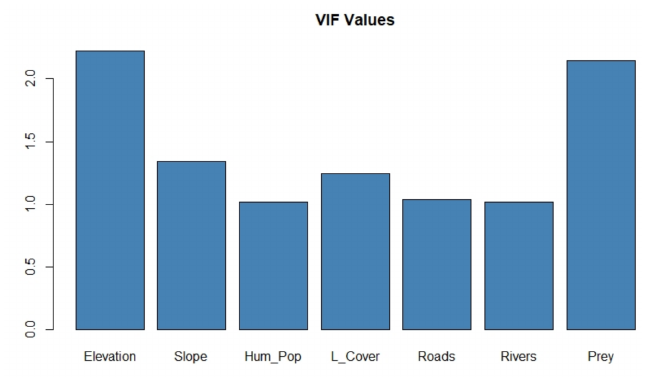
Figure A4. Variance inflation factor (VIF) for variables used in leopard and prey habitat prediction modelling.